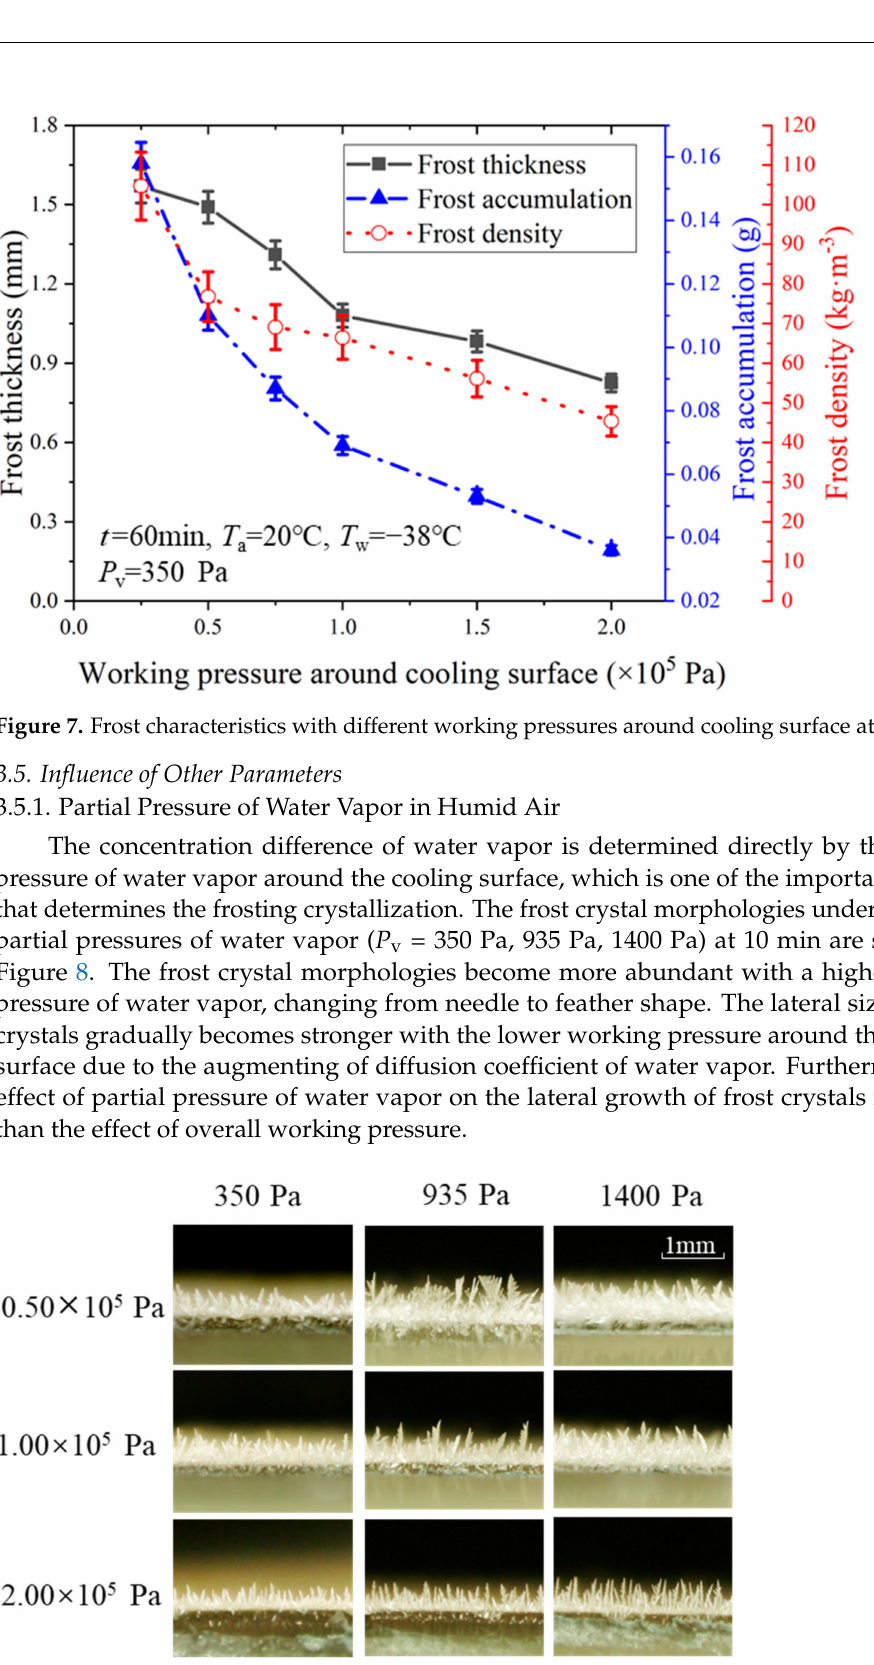
Figure 8. Frost crystal morphologies with working pressure around cooling surface under different partial pressures of water vapor at 10